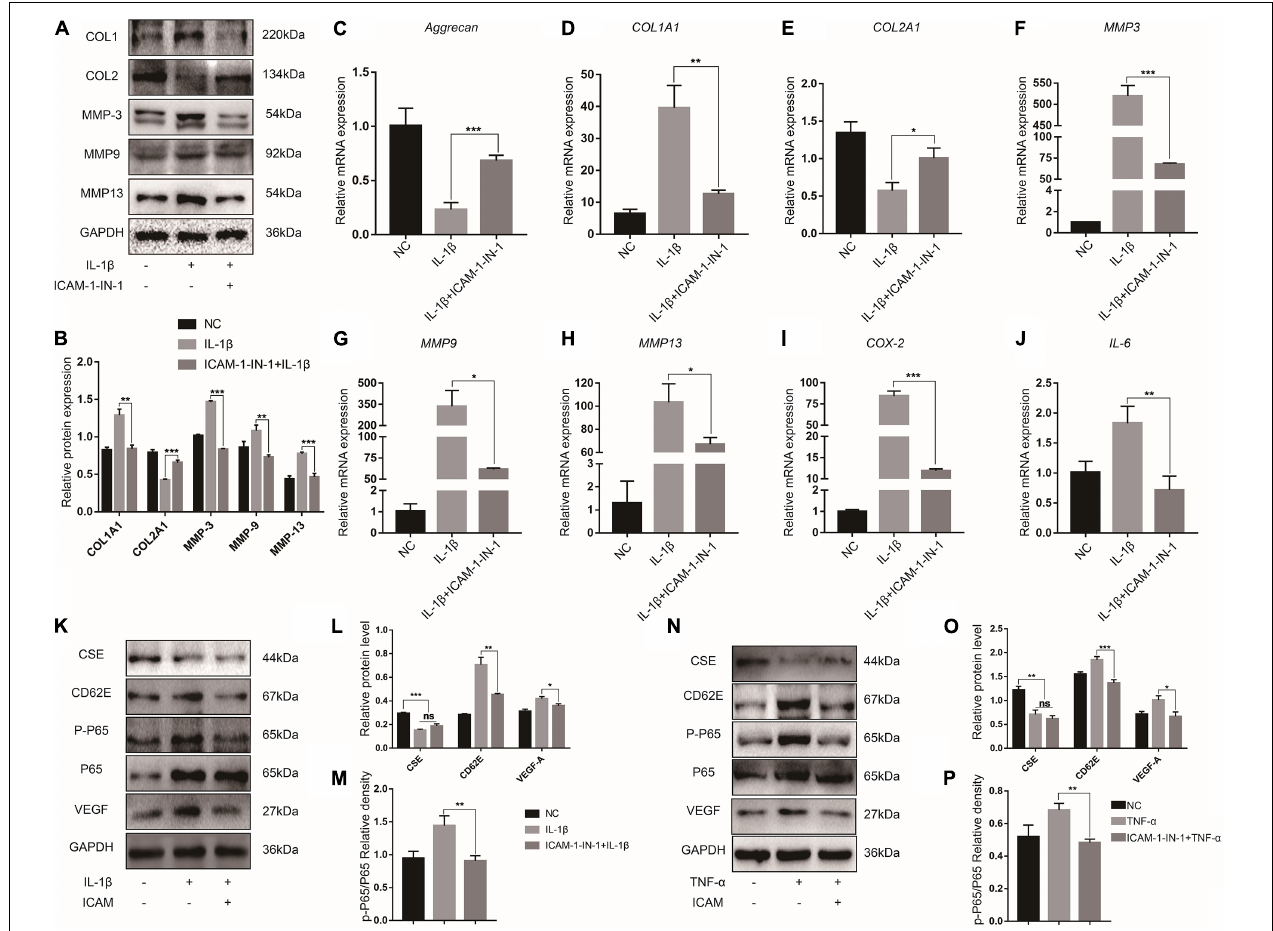
FIGURE 4 | Blocking CD62E influences inflammatory NP cells. (A) Representative western blot images and (B) quantification of effect of blocking CD62E in NP cells. (C–J) RT-PCR measurement of mRNA levels of ECM-encoding genes, ECM-degrading genes, and secreted inflammatory factors. (K) Representative western blot images of CSE, CD62E, P65, p-P65, and VEGF-A and (L,M) quantification (IL-1 β ). (N) Representative western blot images of CSE, CD62E, P65, p-P65, and VEGF-A and (O,P) quantification (TNF- α